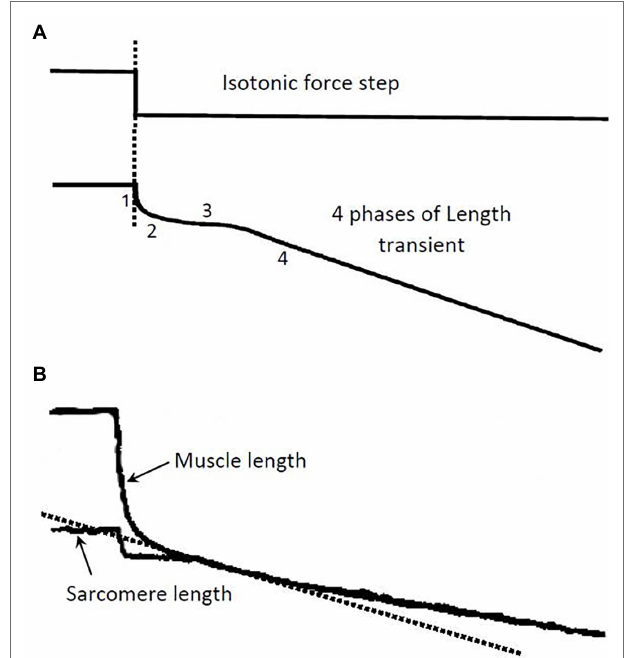
FIGURE 1 | (A) Illustration of a step release in force and the ensuing length transient. The 4 phases of the length response and their underlying causes are described in the text. The isotonic load after the release is kept constant during the transient and the phase 4 contraction (Modified from Seow, 2013). (B) Records from an experiment showing length response to a force step. A skinned single fiber of rabbit psoas muscle was used in the experiment. Both the fiber length and the laser-diffracted sarcomere length signals were recorded. The initial slope (dotted line) of the phase 4 response in the sarcomere length record is taken as the shortening velocity corresponding to the isotonic